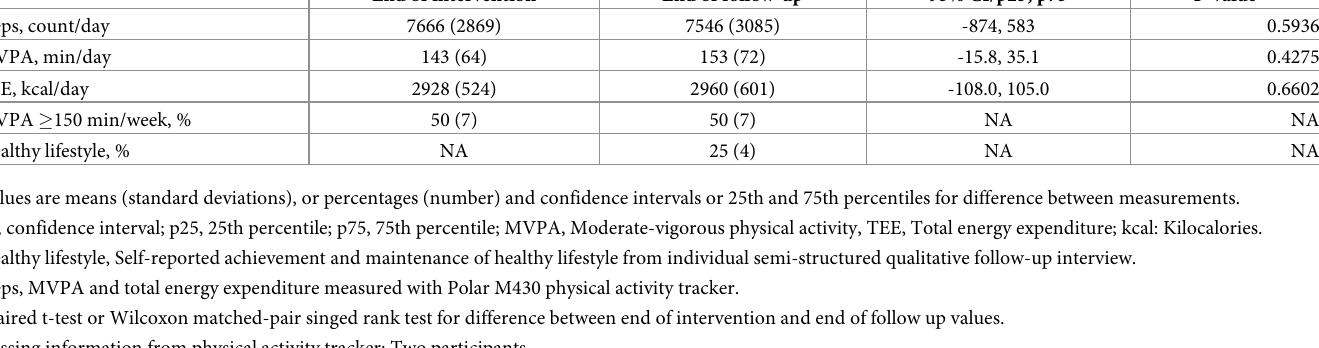
Table 4. Change in physical activity from end-of-intervention to end-of-follow-up, and prevalence of healthy lifestyle achievement and maintenance at end-of-fol- low-up. The RESTART pilot study 2017–18. End of intervention End of follow-up 95% CI/p25, p75 P-value � Steps, count/day 7666 (2869) 7546 (3085) -874, 583 0.5936 MVPA, min/day 143 (64) 153 (72) -15.8, 35.1 0.4275 TEE, kcal/day 2928 (524) 2960 (601) -108.0, 105.0 0.6602 MVPA � 150 min/week, % 50 (7) 50